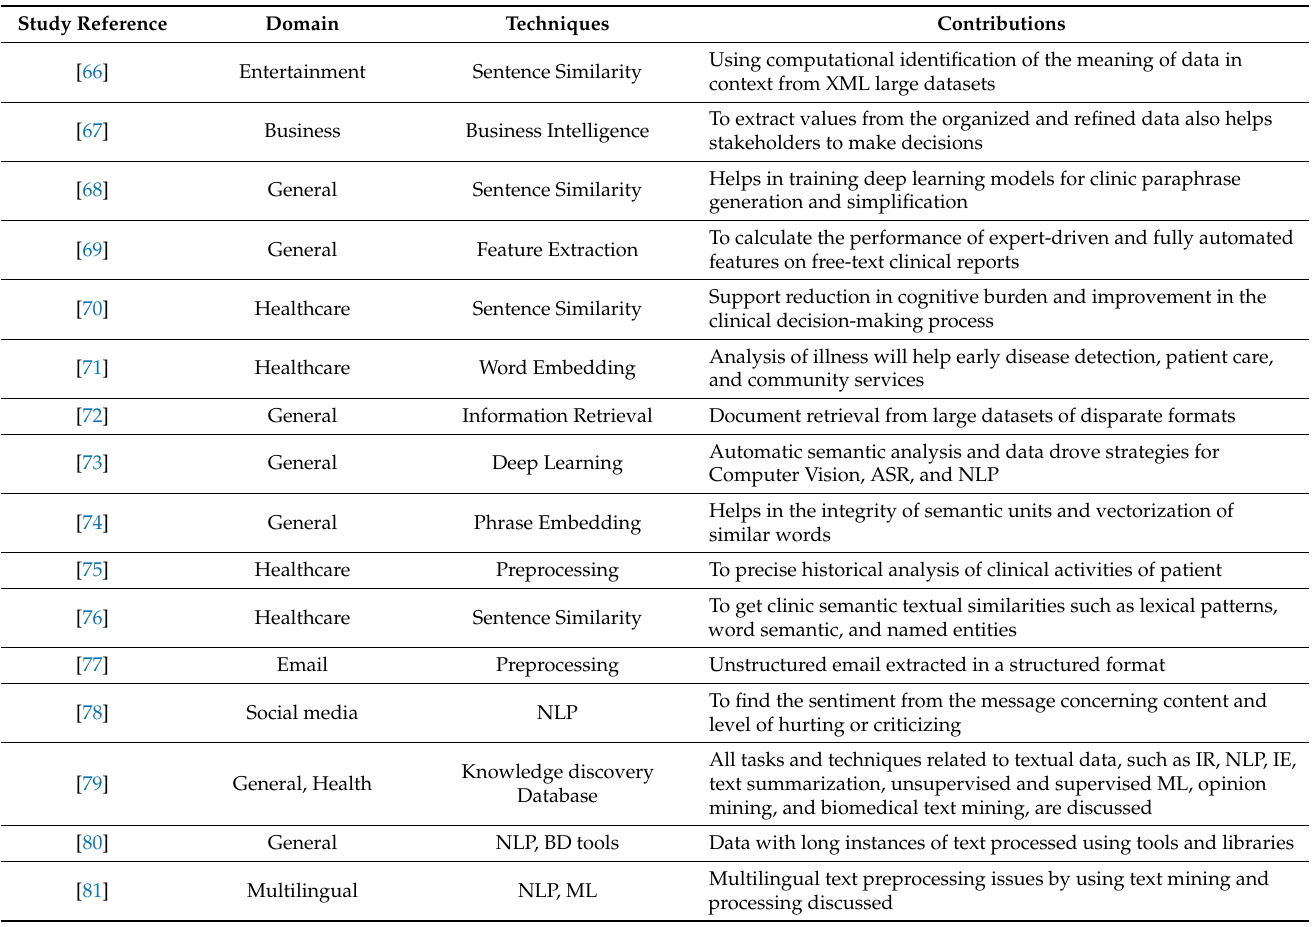
Table 8. Domain, techniques, and